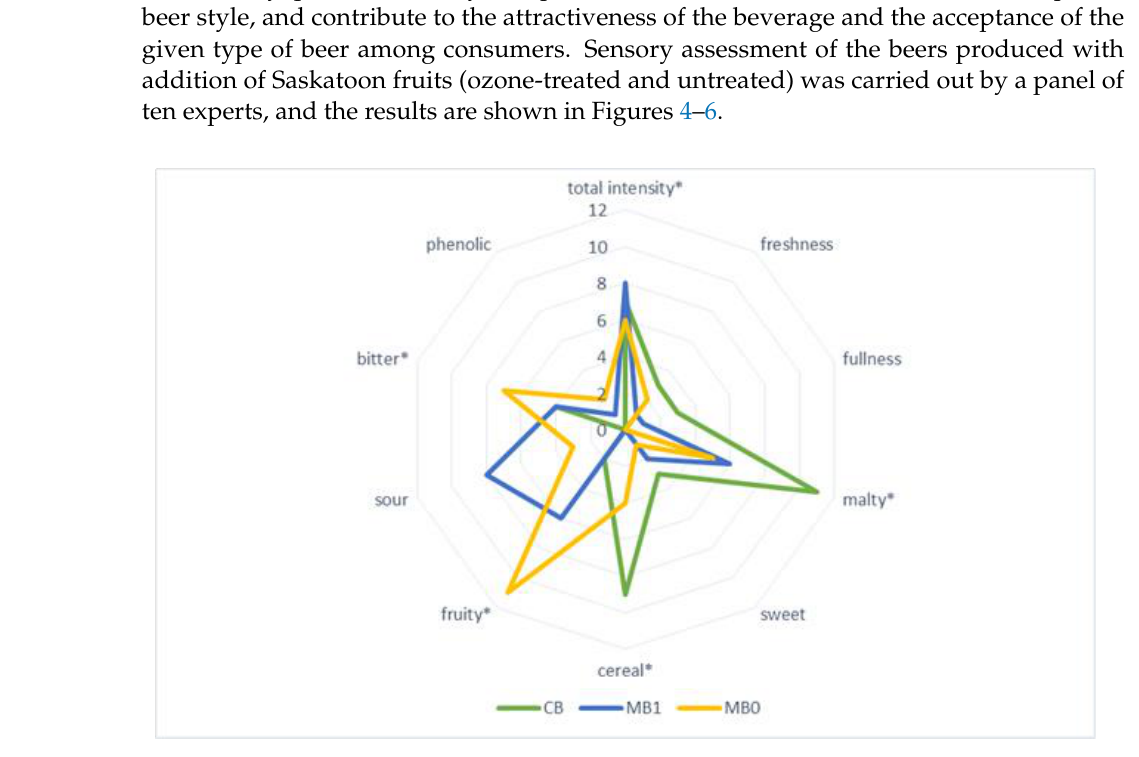
Figure 4. Sensory profile of barley beers —control (CB) and sample with addition of ‘Martin’ cultivar fruit untreated (MB1) and treated with ozone (MB0); * marks the attributes which were statistically different at p ≤ 0.05.